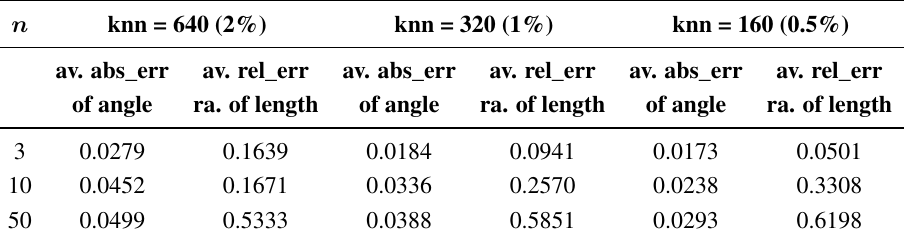
Table 9. The results of (cid:96) MCDA on four superimposed Student t distributions with 10% 1 artificial